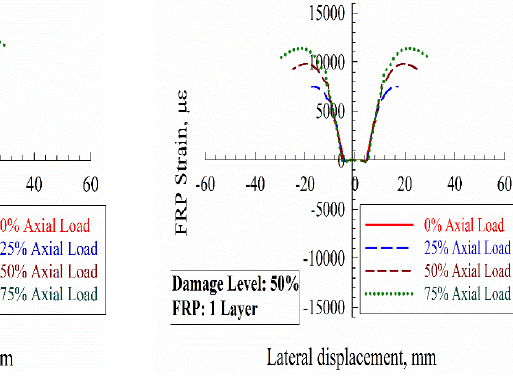
Figure 13. FRP’s Figure 13. FRP’s strains.